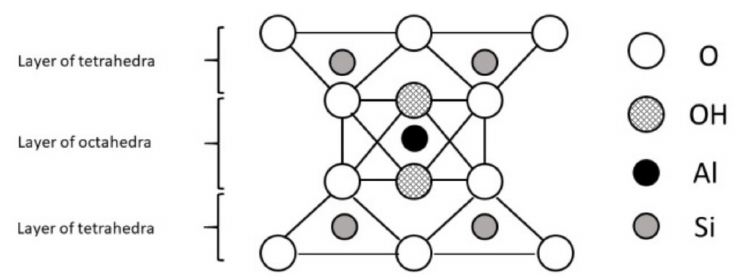
Figure 1. The 1:1 layer phyllosilicate structure.